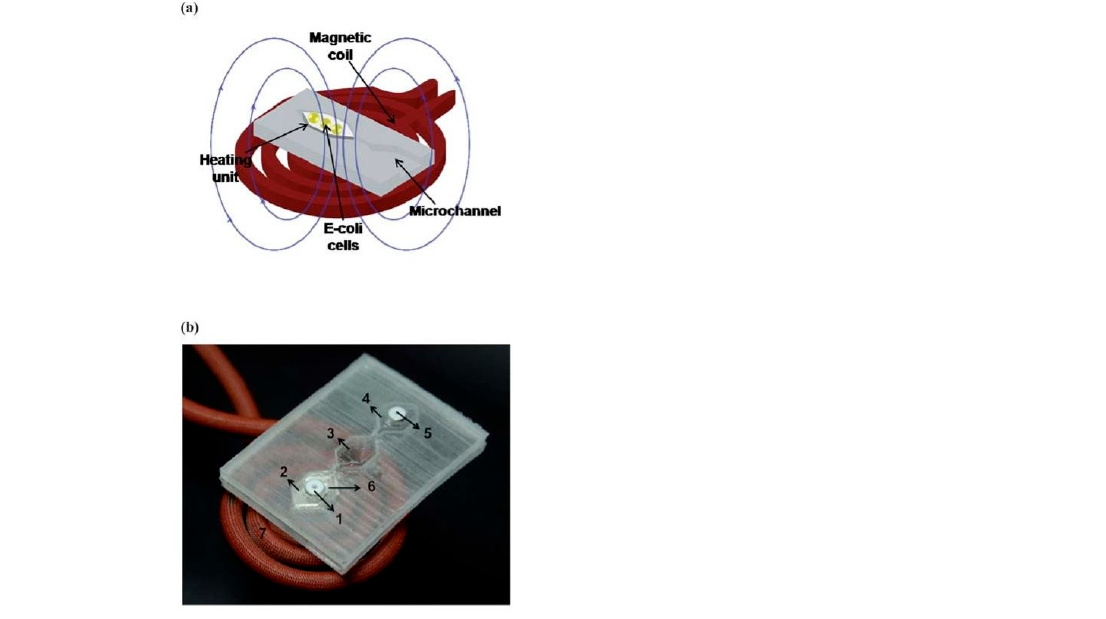
Figure 26. Representation ( a ) and a photograph ( b ) of the integrated microfluidic system utilized in [101]. A metal heating unit with a hexagonal shape was embedded in a bottom layer of polydimethylsiloxane and a hexagonal metal heating unit was heated at a specified magnetic field. Adapted with permission from [101]. Copyright 2010 Royal Society of Chemistry.